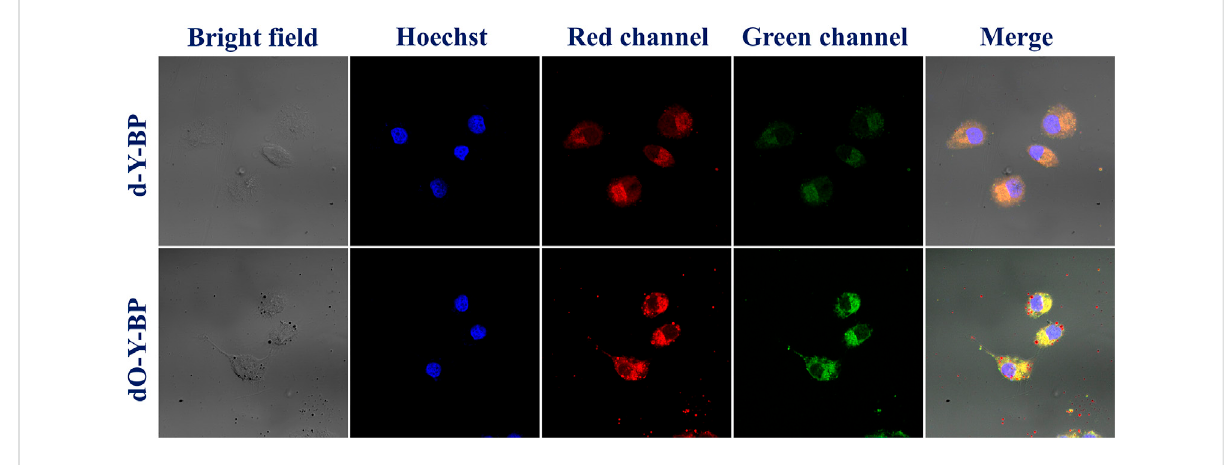
FIGURE 4 Fluorescent microscope imaging of treated HeLa cells with d/dO-Y-BP for 48 h.